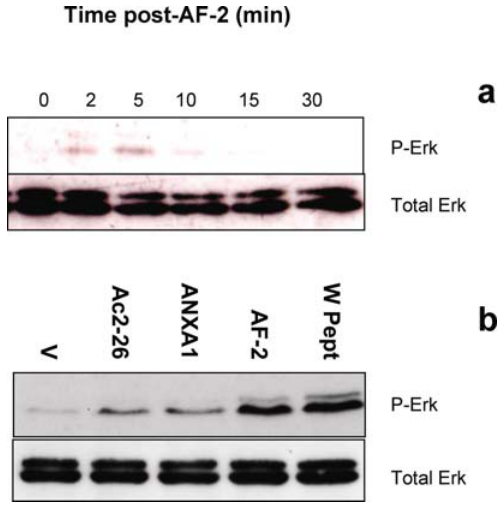
FIGURE 3. AF-2–induced ERK activation in FPRL-1 HEK cells . Panel a, time-dependent increases in ERK activation in FPRL-1-HEK cells incubated with 10 µ M AF-2. Panel b, ERK phosphorylation produced by FPRL-1-HEK cell incubation (10 min) with peptide Ac2-26 (10 µ M ), ANXA1 (0.5 µ M ), AF-2 (10 µ M ), or W-peptide (10 µ M ). Data are representative of two to four independent